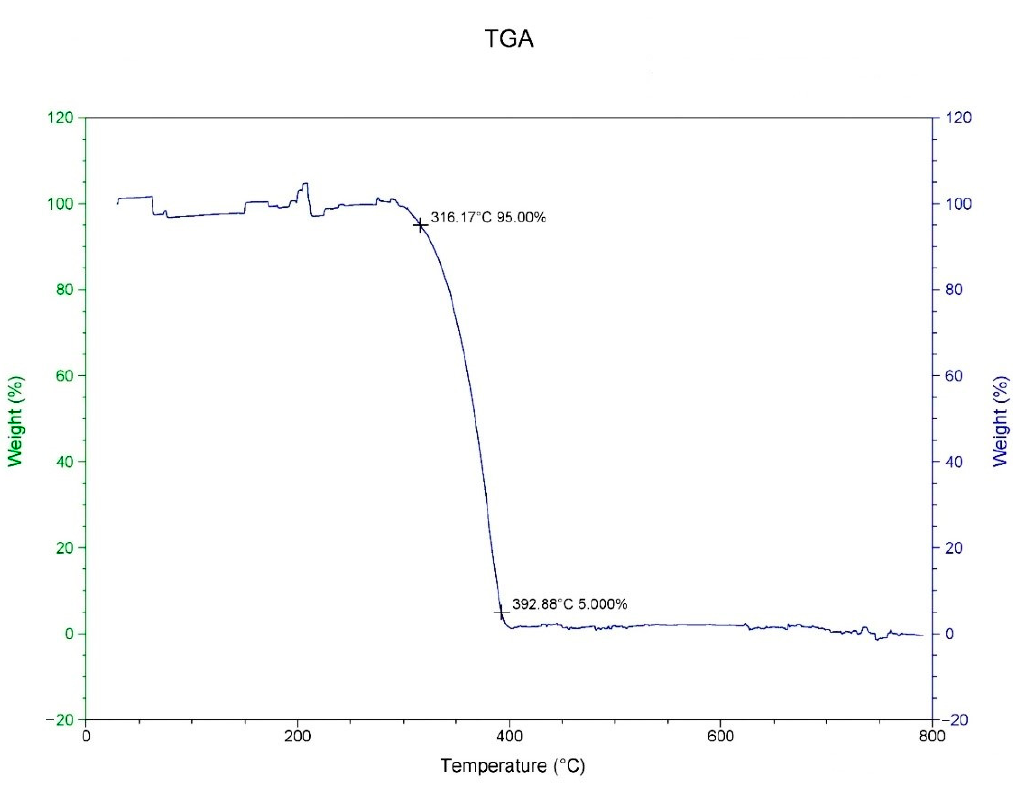
Figure 1. Analysis of thermo gravimetric loss of PP.